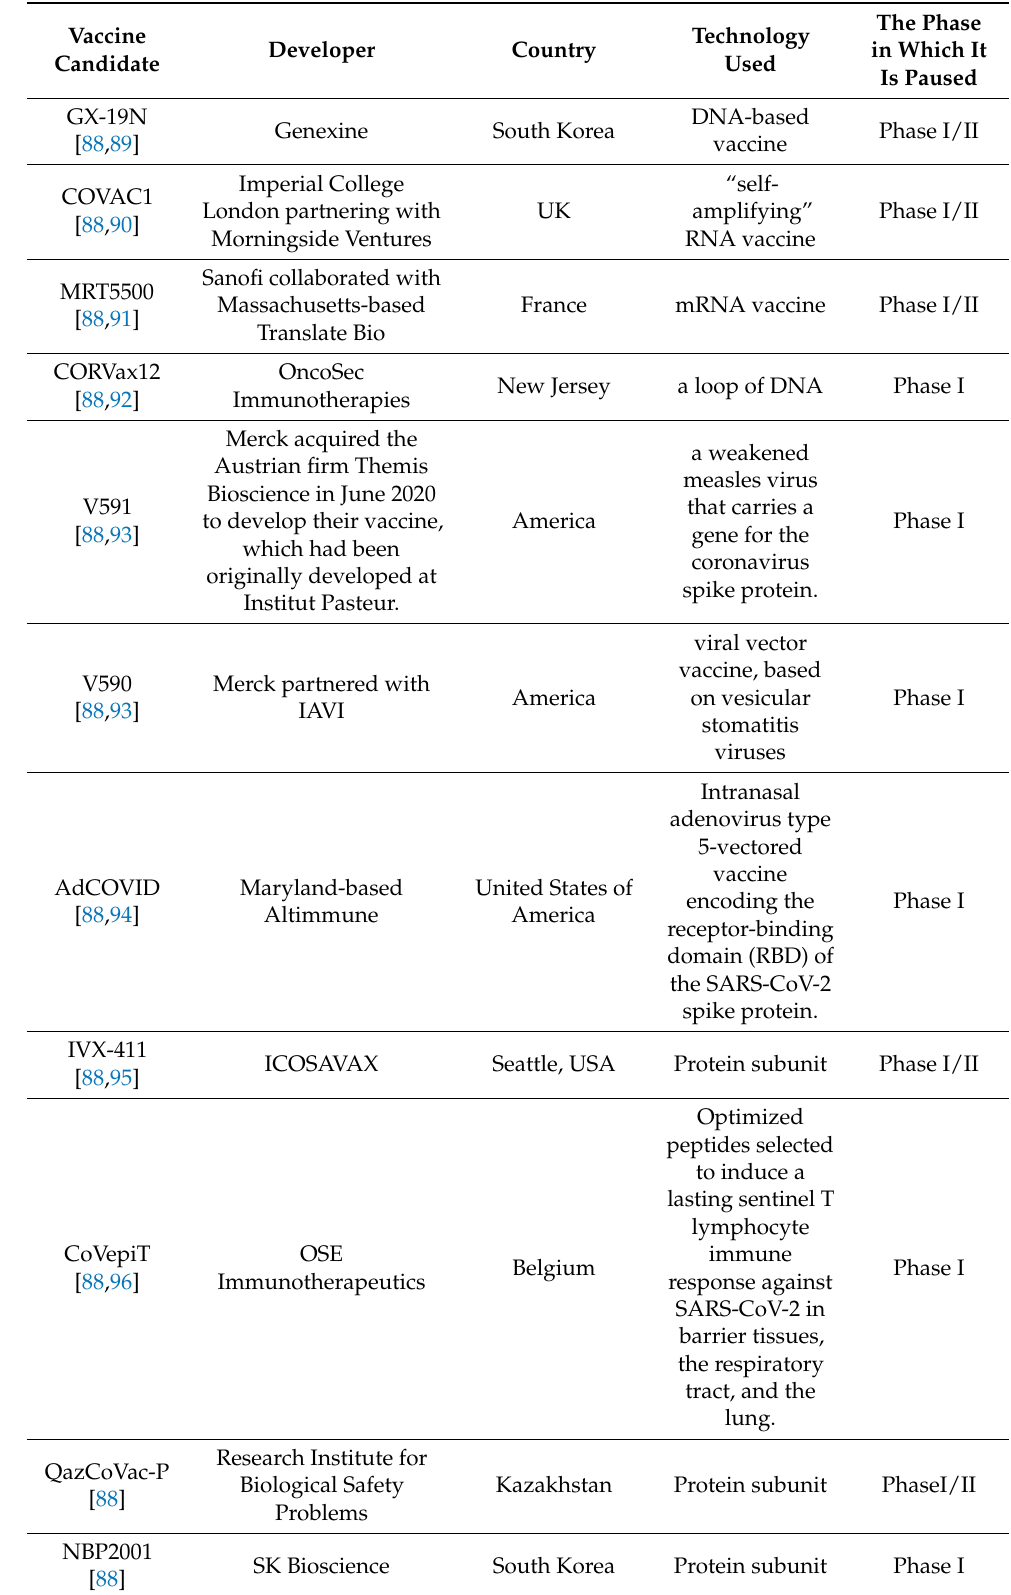
Table 2. Vaccine candidates that went to phase I–II but were